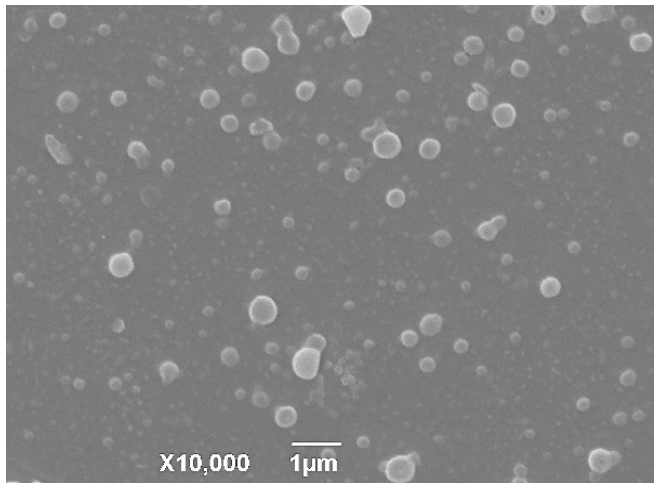
Figure 2. The SEM imaging of TIL-SLNs (tilmicosin-loaded solid lipid nanoparticles). The TIL-SLNs showed a spherical shape with a relatively narrow polydisperse.